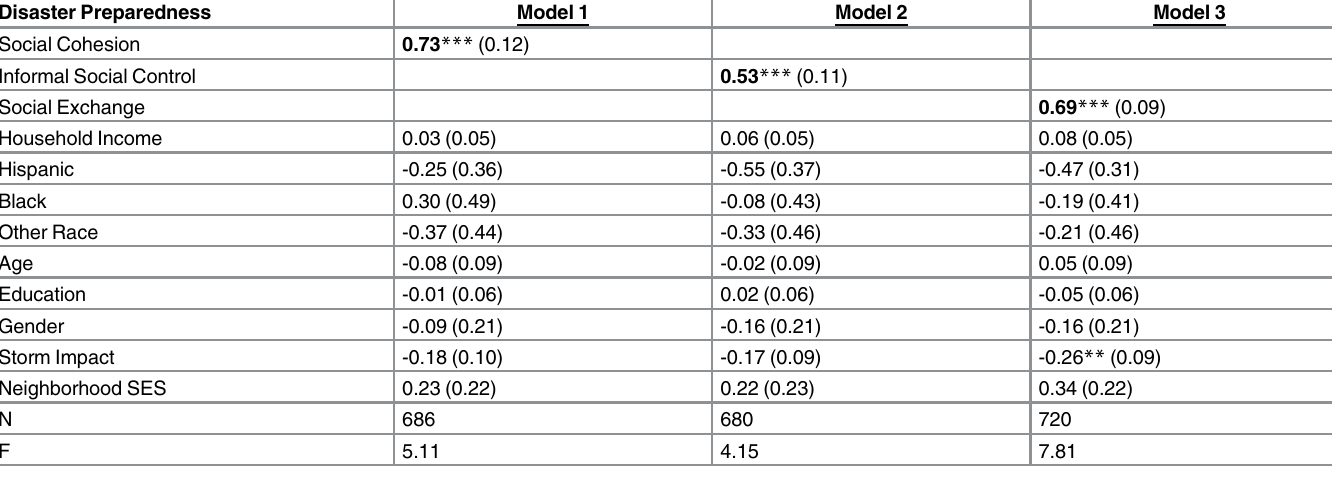
Table 2. Social cohesion, social control and social exchange and their associations with beliefs about disaster